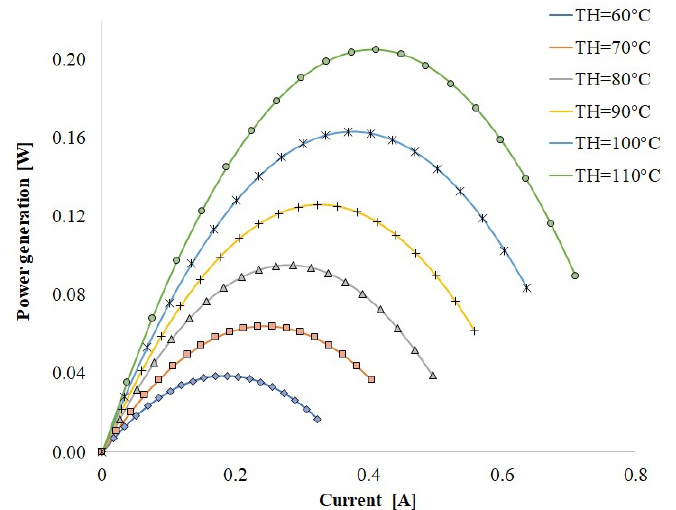
Figure 7. Comparison of experimental data (discrete data) and model predictions (continuous lines) for TEG module using model’s parameters found by the VSA method for several temperature differences; T cold = 24.3 ◦